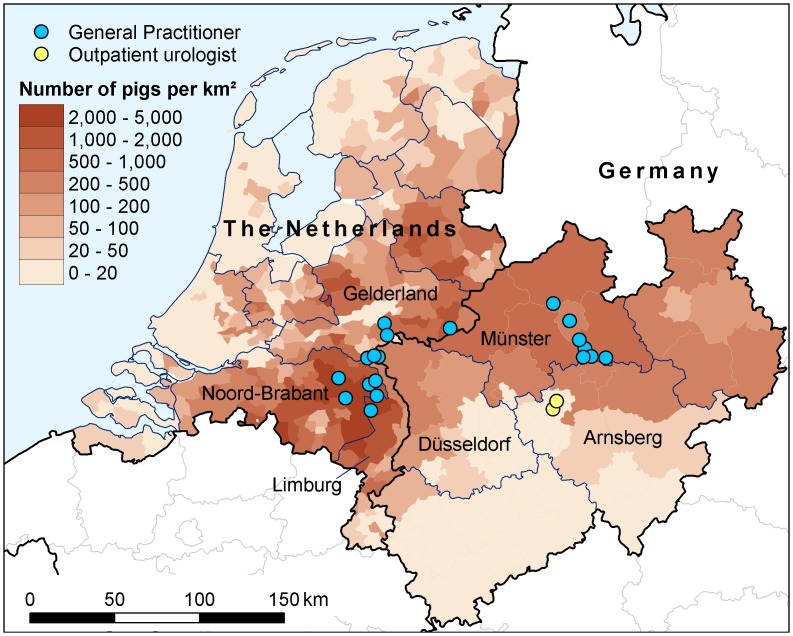
Map of the Netherlands and the German federal state of North Rhine-Westphalia: pig-density rates (pigs per km2) and location of GPs and outpatient urologists.Note: The pig-density data for the Netherlands is from 2012 and for North Rhine-Westphalia it is from 2010 (the most recent data available for both countries).